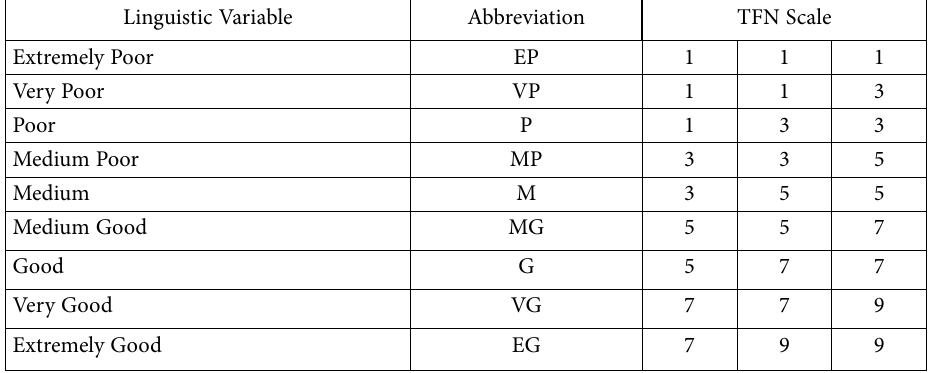
Table 7. Linguistic comparison scales for decision options (Stankovic et al.,